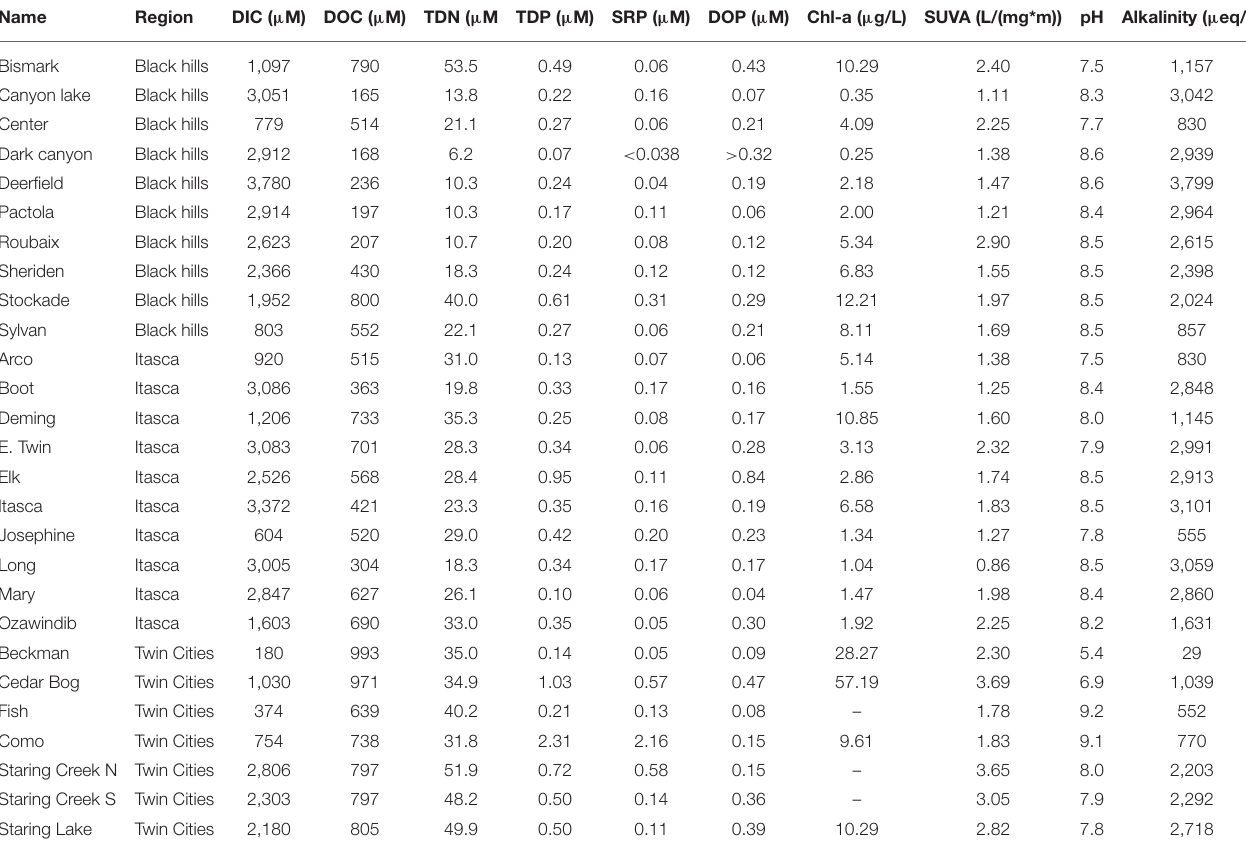
TABLE 1 | Table showing general characteristics of each of the 27 sampling sites.